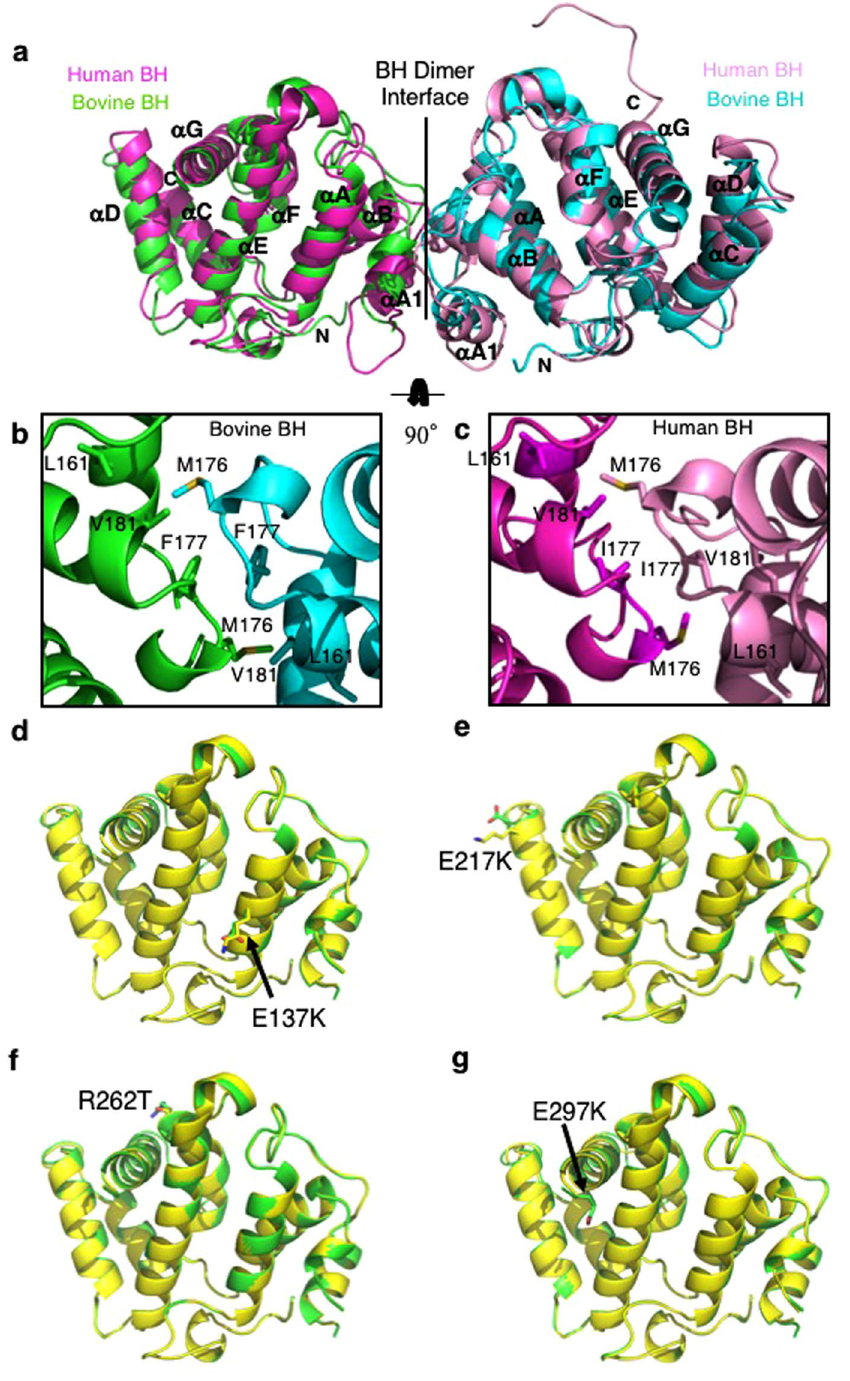
Figure 3. Crystal structures for bovine p85 α (105–319) wild type and containing patient-derived mutations. ( a ) Overlay of the bovine p85 α (105–319) crystal (green and cyan, resolution 2.25 Å) with the crystal structure for the human p85 α (105–319) protein fragment (1PBW; magenta and pink, resolution 2.0 Å). A homodimer of the bovine p85 α BH domains was visible containing residues 113–297 for both components of the dimer. ( b,c ) p85 α BH domain residues involved in the hydrophobic dimerization interface within the crystal lattice of the bovine protein ( b ; L161, M176, F177 and V181) and the human protein ( c ; L161, M176, I177 and V181). ( d – g ) Overlays of the crystal structures for p85 α (105–319); wild type (green) and cancer-associated point mutants (yellow): E137K mutant ( d ), E217K mutant ( e ), R262T mutant ( f ), E297K mutant ( g ). Wild type and mutant sidechains are shown in stick representation. Lack of density for the K297 sidechain prevented inclusion of the sidechain, and it is modeled as Ala in the structure ( e